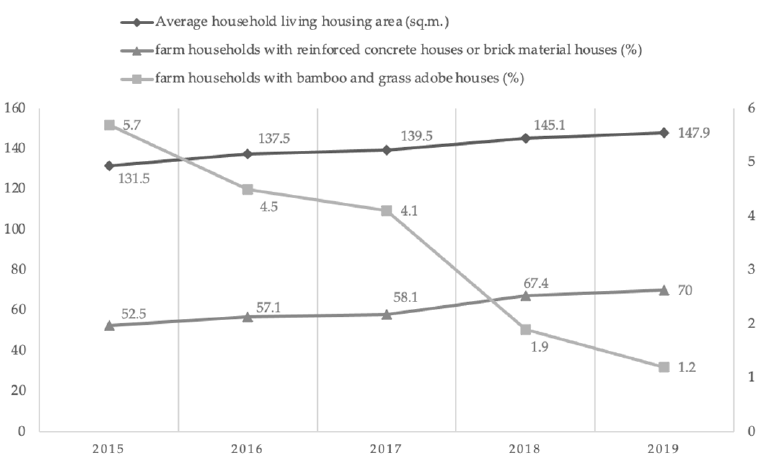
Figure 1. Trends in housing conditions of residents in poor areas in China, 2015–2019. Source: China Rural Poverty Monitoring Report.